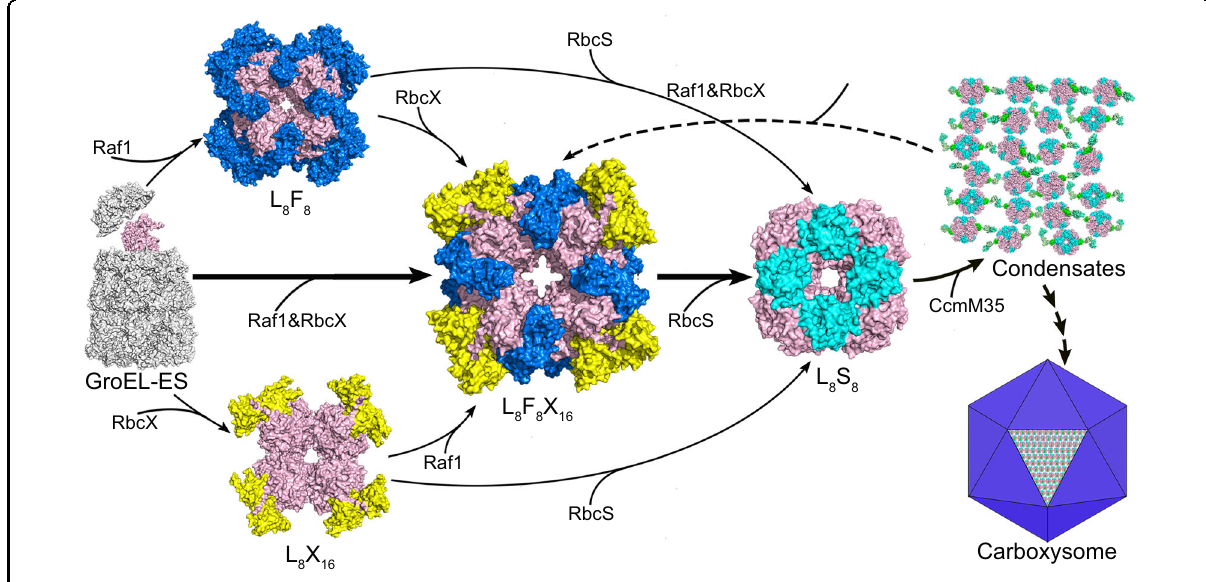
Fig. 4 An updated model of cyanobacterial RuBisCO assembly assisted by Raf1 and RbcX. The previously identi fi ed paths of individual Raf1- or RbcX-assisted RuBisCO assembly are also included in the model. The proteins GroEL-GroES, RbcL, RbcS, Raf1, and RbcX are shown as surfaces and are colored in gray, pink, cyan, marine, and yellow, respectively. A putative step of condensates disassembly is indicated by the dashed